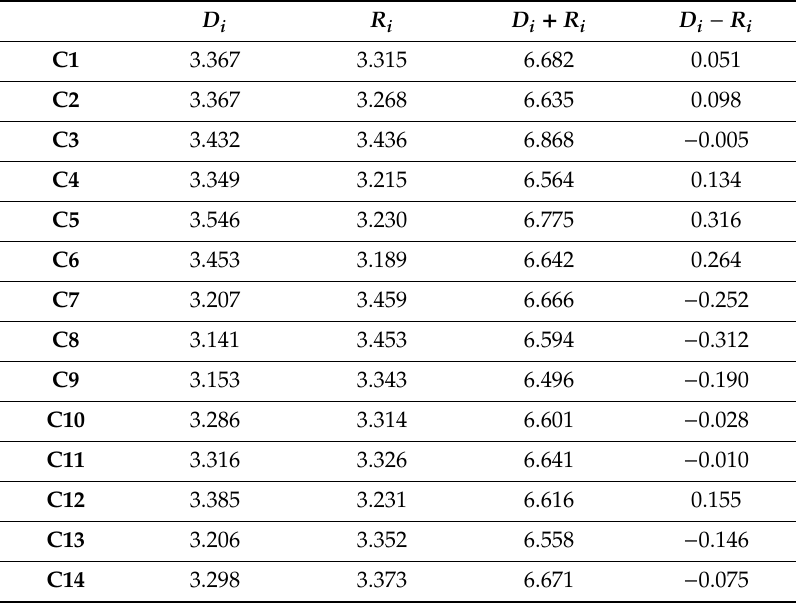
Table 5. The prominence and relation for cause and e ff ect.